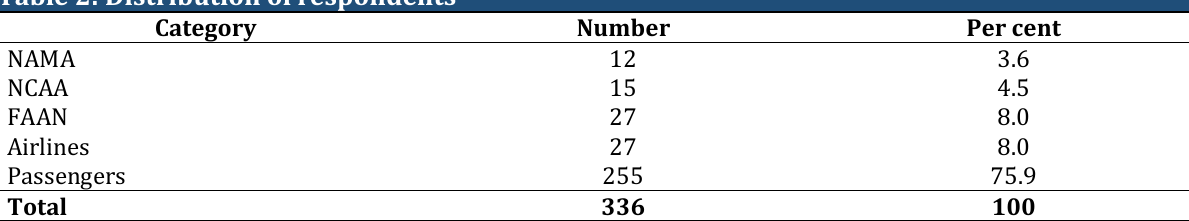
Table 2: Distribution of respondents